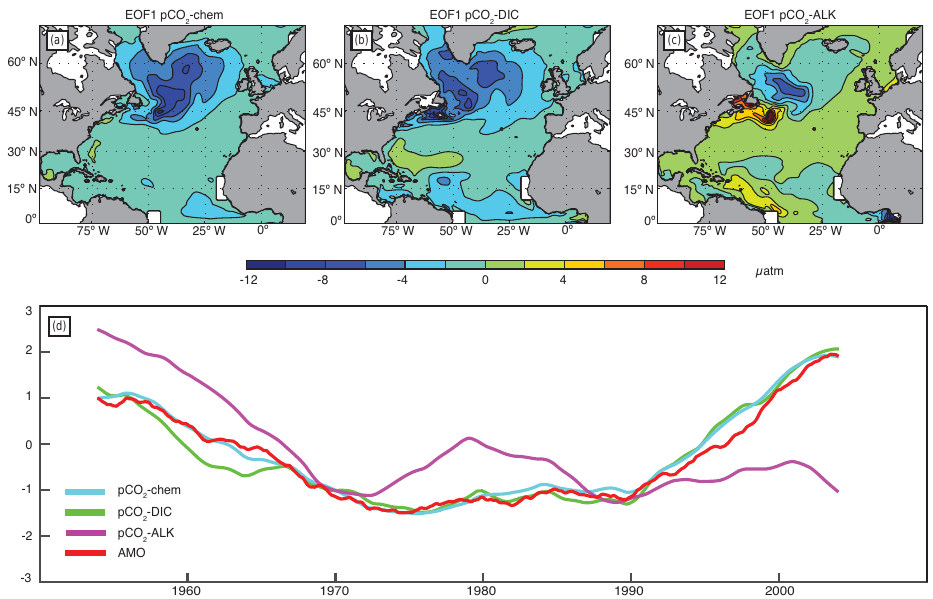
Figure 2. (a) EOF1 p CO 2 -chem (µatm), (b) EOF1 p CO 2 -DIC (µatm), and (c) EOF1 p CO 2 -ALK explaining 32, 25, and 19% of total variance, respectively; (d) PC1- p CO 2 -chem (cyan), PC1- p CO 2 -DIC (green), PC1- p CO 2 -ALK (magenta), and AMO index (red), all stan- dardized. Time series smoothed with a 121-month box